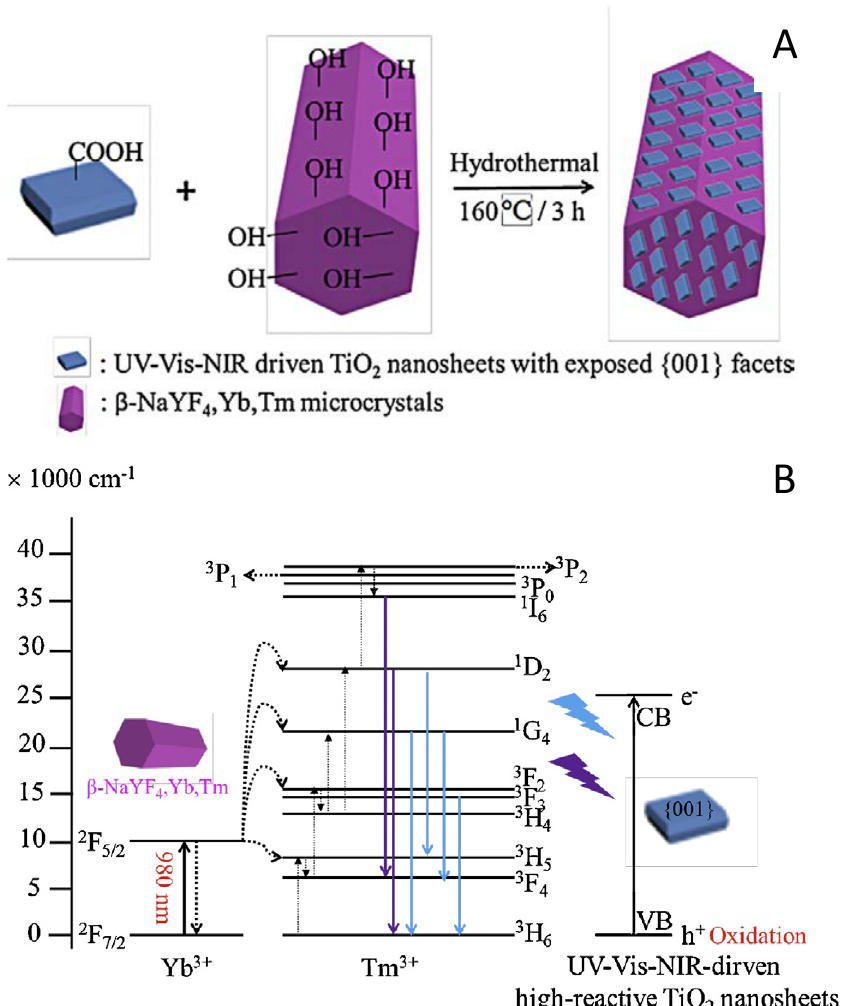
Figure 8. Schematic illustration of preparation method and structure of NaYF 4 @TiO 2 photocatalyst ( A ). Schematic illustration of energy transfer mechanism from Yb 3+ -Tm 3+ doped hexagonal phase NaYF 4 microrods to {0 0 1} facets dominated UV–vis–NIR driven TiO 2 nanosheets under the 980 nm light irradiation ( B ). Reprinted with permission from [109]: Wang, W. et al. Appl. Catal. B 2014, 144,